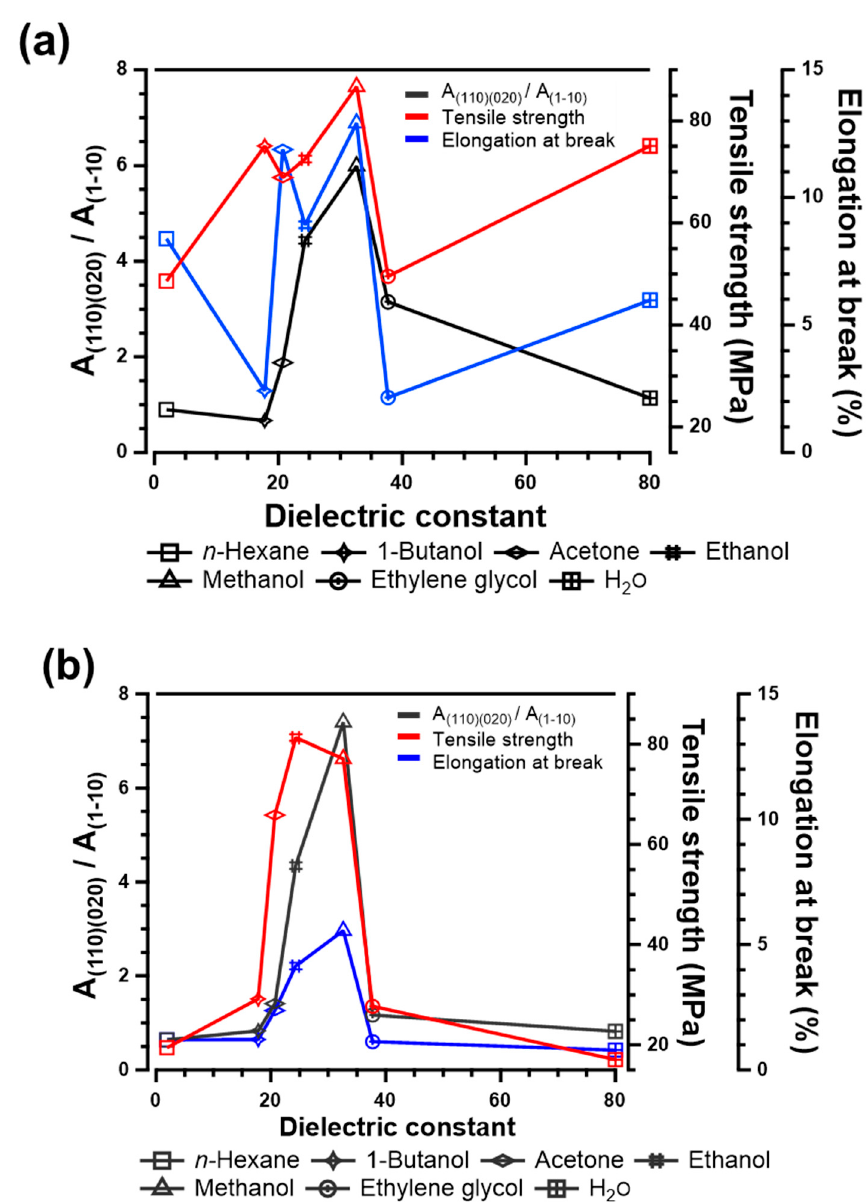
Figure 7. Crystal occupancy and mechanical properties of regenerated cellulose films prepared from ( a ) CNF and ( b ) MCC ( a ) CNF and ( b ) MCC as a function of coagulants dielectric as a function of coagulants dielectric constant.